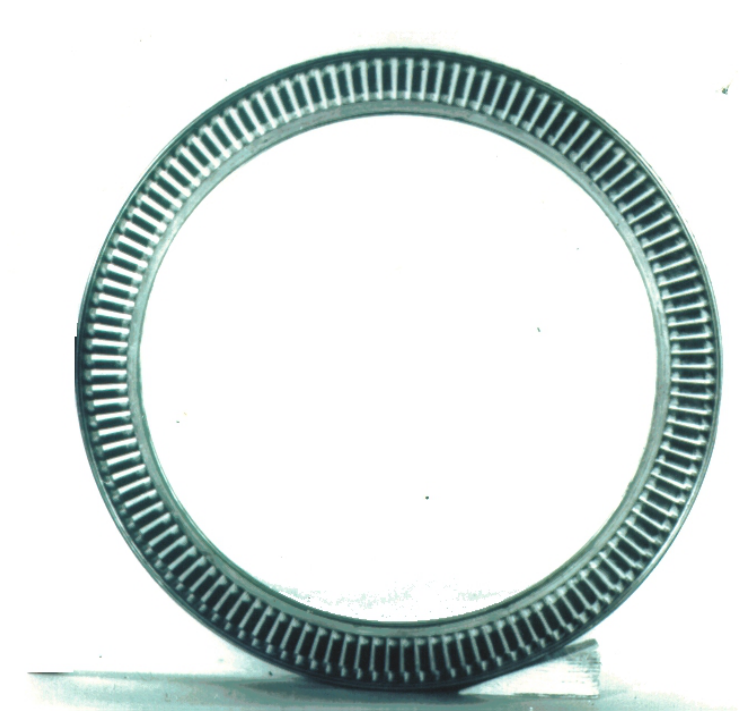
Fig. 7. Jet engine stator